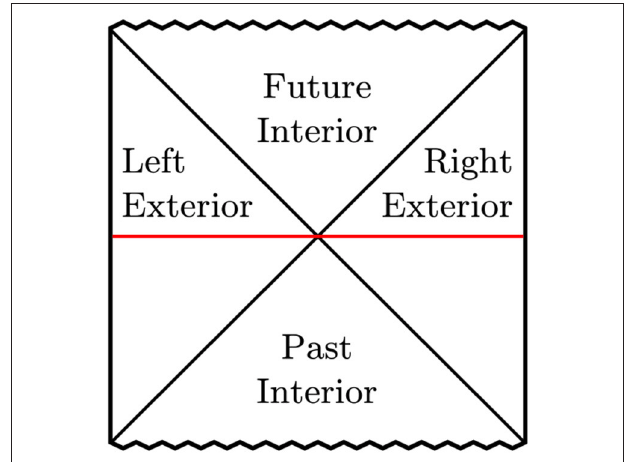
FIGURE 9 | Extended AdS-black hole with two boundaries connected by a wormhole or Einstein-Rosen bridge (horizontal line).